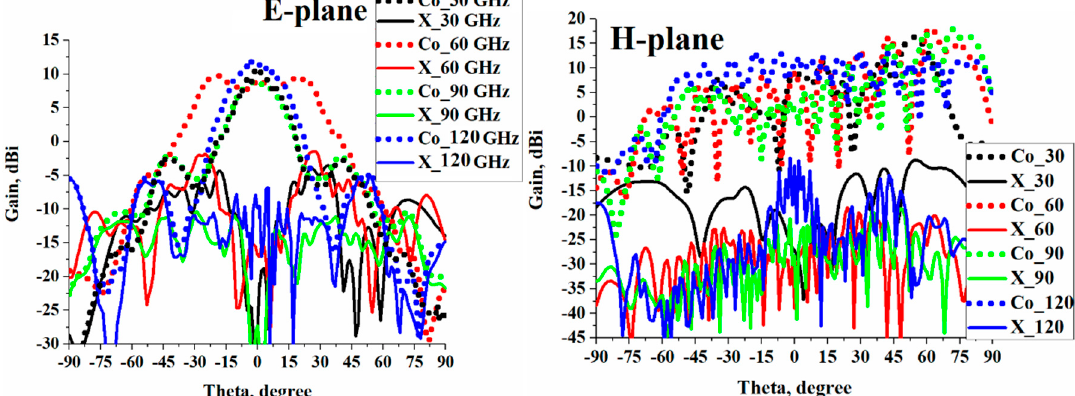
Figure 6. Co- and cross-radiation patterns of the proposed microstrip antenna arrays “with” slots in the E- and H-planes at spot frequencies over its operating band.